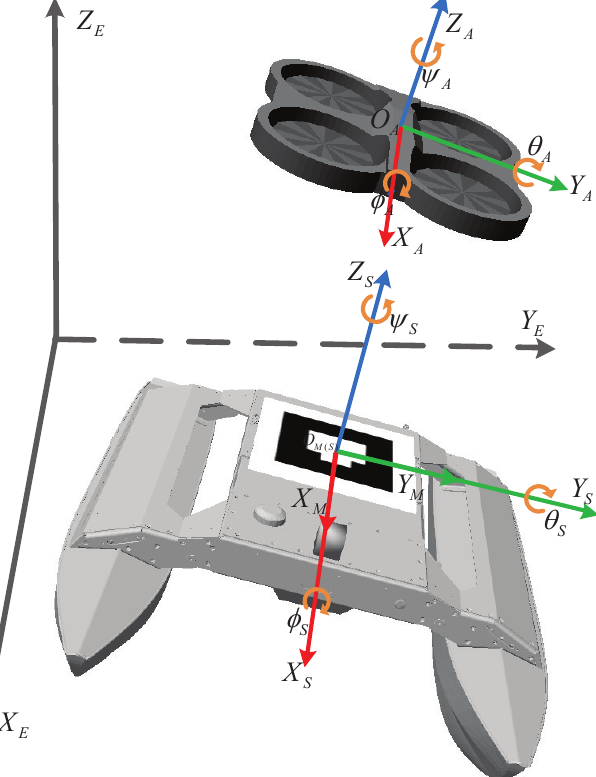
Figure 1. UAV–USV synchronous movement coordinate system. O E − X E Y E Z E is the earth coordi- nate system, defined by East − North − Up (ENU). The carrier coordinate system includes the UAV coordinate system O A − X A Y A Z A and the USV coordinate system O S − X S Y S Z S , which is defined by Front − Left − Up (FLU). O M − X M Y M is the landing mark coordinate